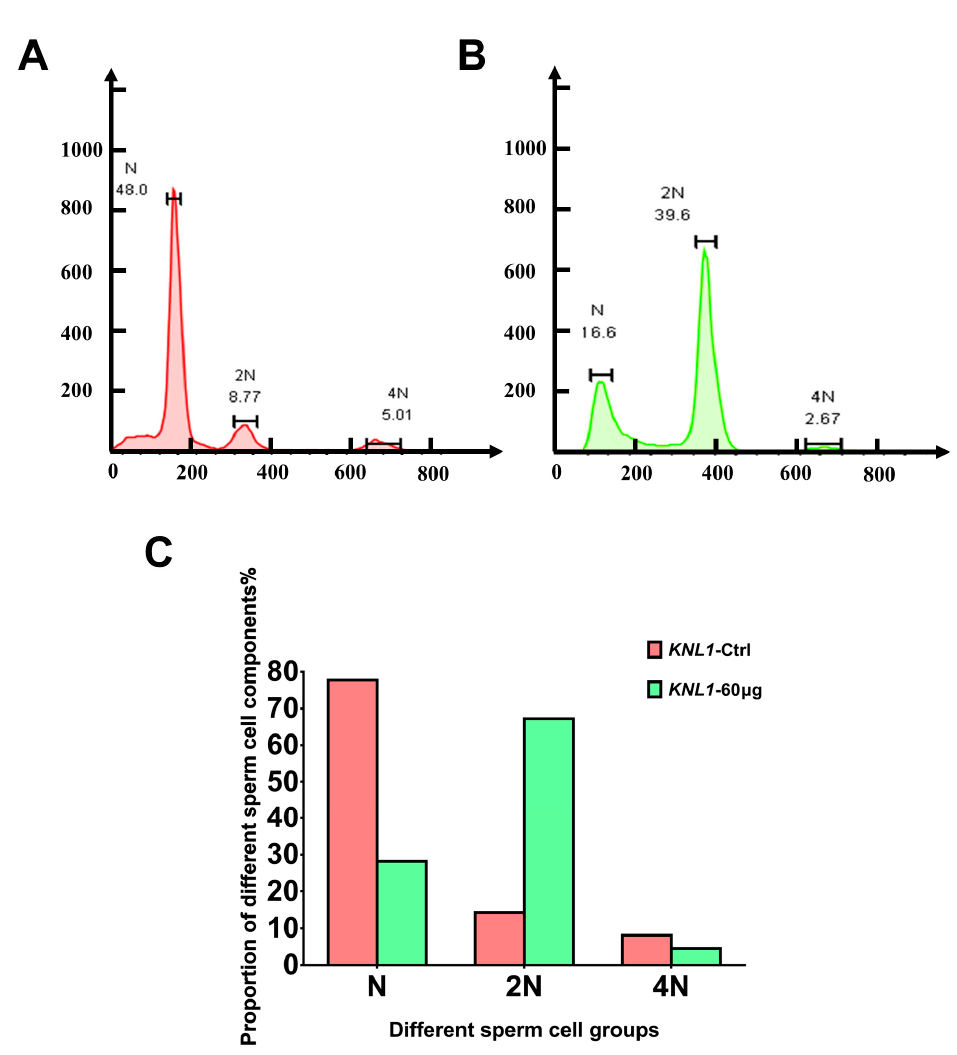
Figure 6. Effects of loss-function of KNL1 on the spermatogenic process by FCM. ( A ) The FCM results of KNL1 -Ctrl mice. ( B ) The FCM results of KNL1 -60 µ g mice. N, 2N, and 4N represents a different period of sperm in spermatogenesis ( A , B ). ( C ) The percentage of sperm with different ploidy. All data were at least measured by three independent